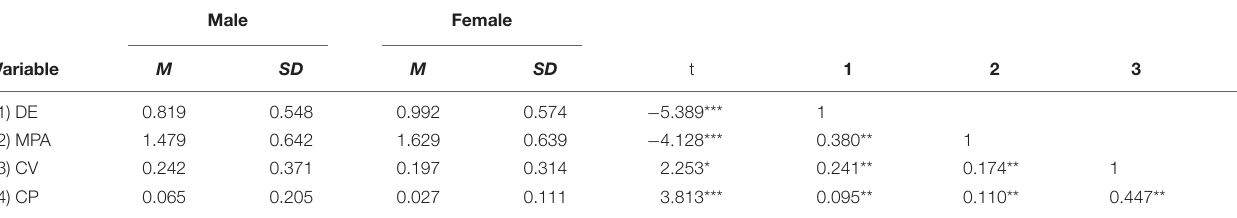
TABLE 1 | Describes statistics and correlation analysis matrix of variables. Male